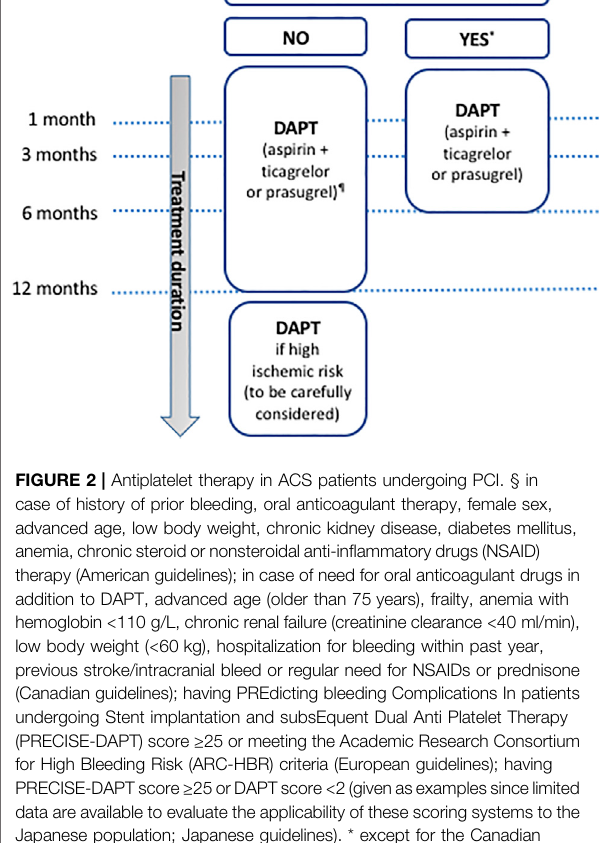
Frontiers in Pharmacology |